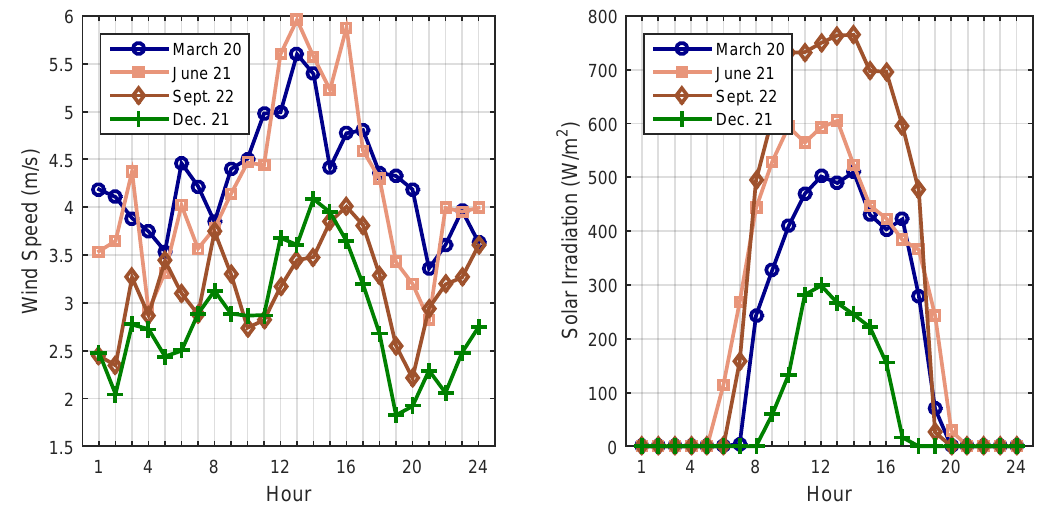
Figure 6. Average wind speed and solar irradiation at the study location (Salt Lake